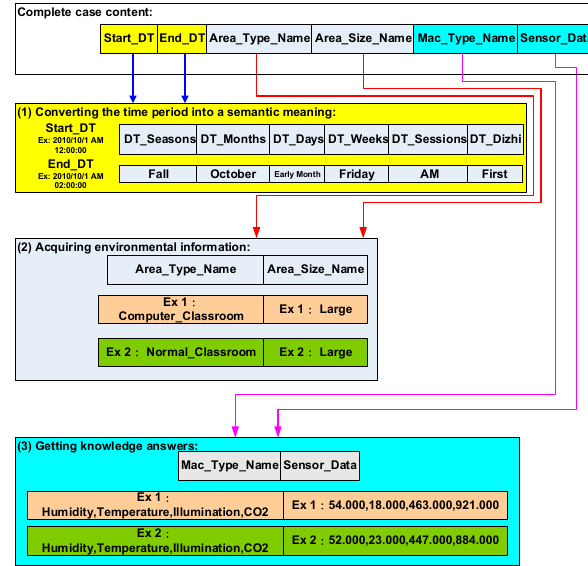
Figure 9. Practice example of a case generation.